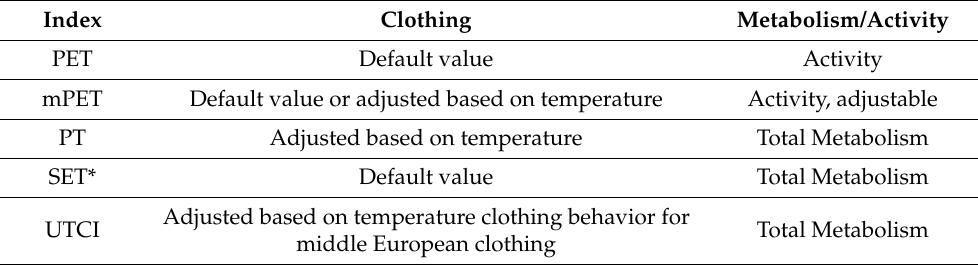
Table 1. Clothing and heat production (metabolism/activity parameters) for thermal indices input. Index Clothing